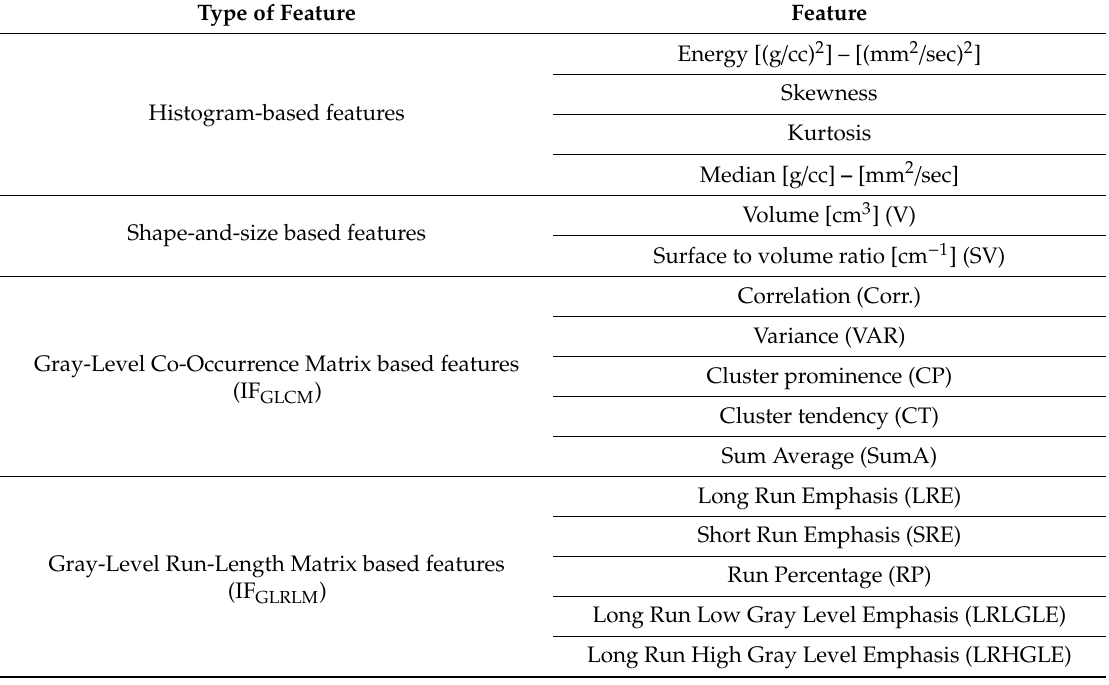
Table 5. Sixteen selected features from imaging analysis to be correlated with